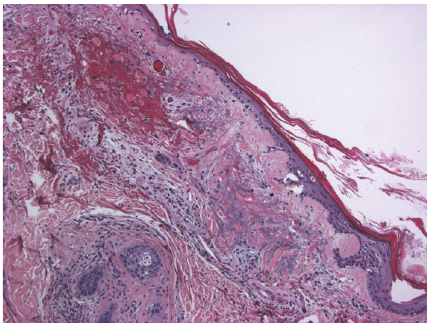
Figure 2: Epidermal atrophy with prominent basement membrane (H&E 100x). Dermal edema with blue mucin and mild perivascular mononuclear infiltrate (mainly lymphocytes).